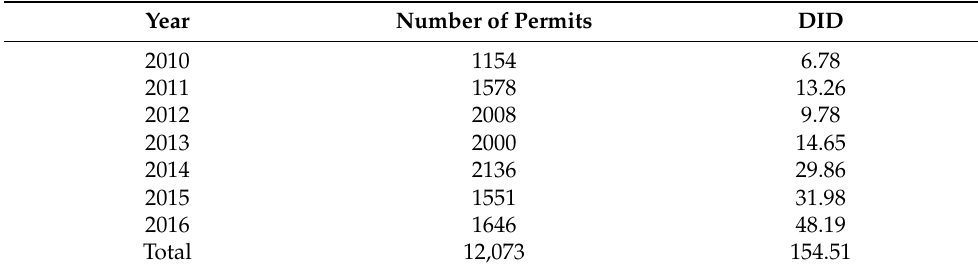
Table 1. Yearly distribution of DIDs and number of